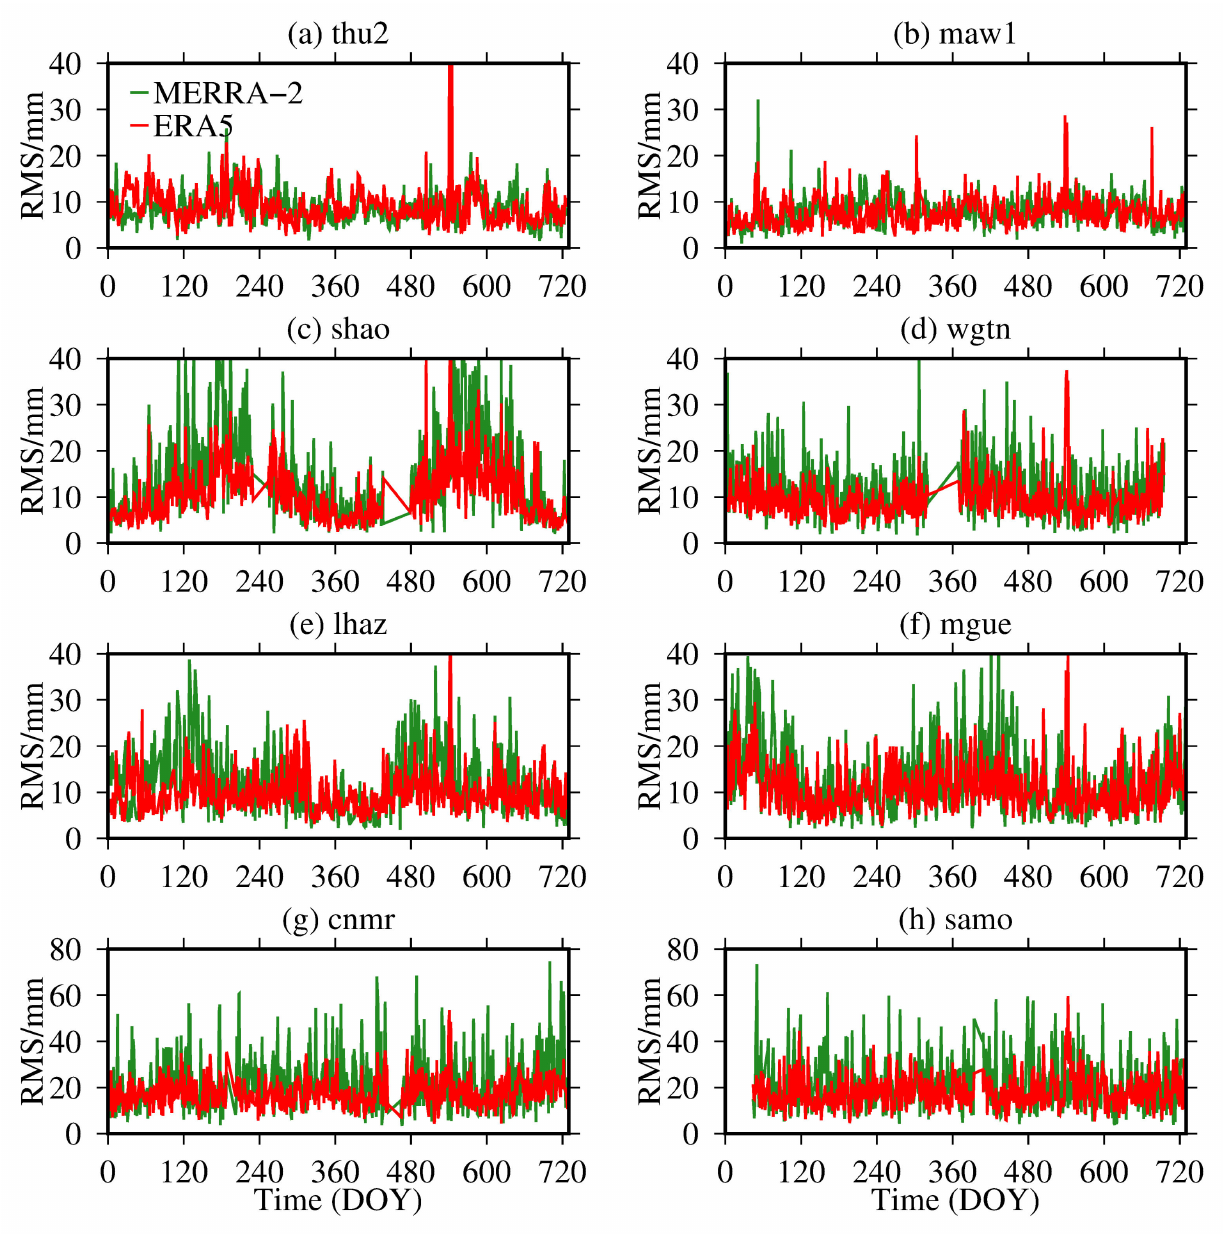
Figure 5. ( a – h ) Time series of MERRA-2 and ERA5 pressure-level ZTD RMS in 8 GNSS